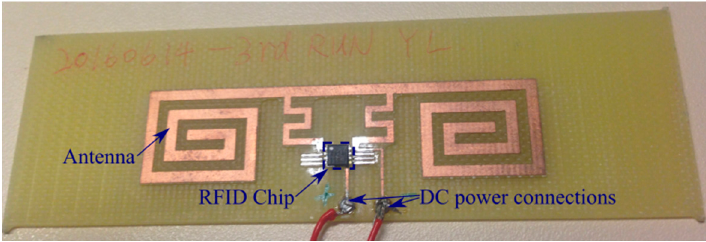
Figure 3. Photograph of the RFID communication module.